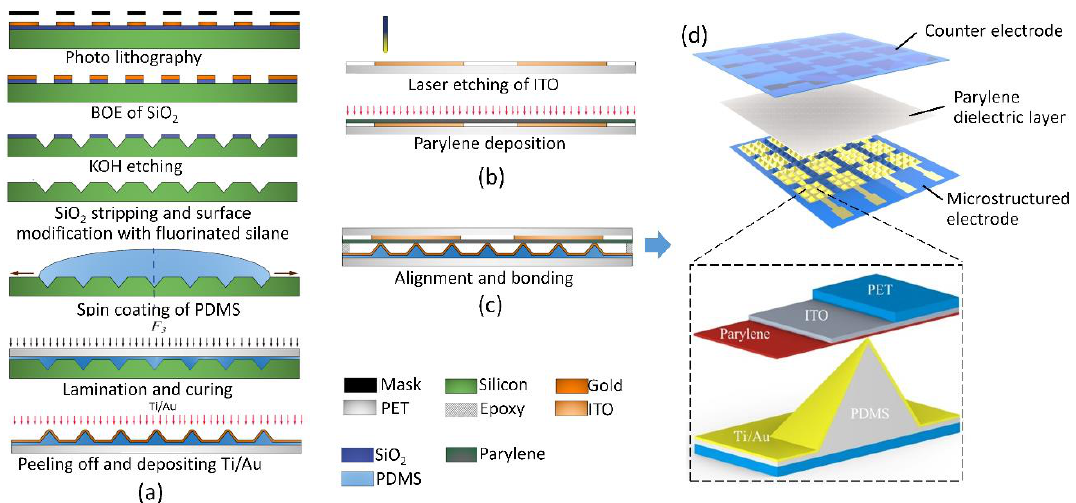
Figure 1. Fabrication process of the ( a ) microstructured electrode, ( b ) counter electrode, and ( c ) final sensor array; ( d ) illustration of the capacitive pressure sensor based on a microstructured electrode.